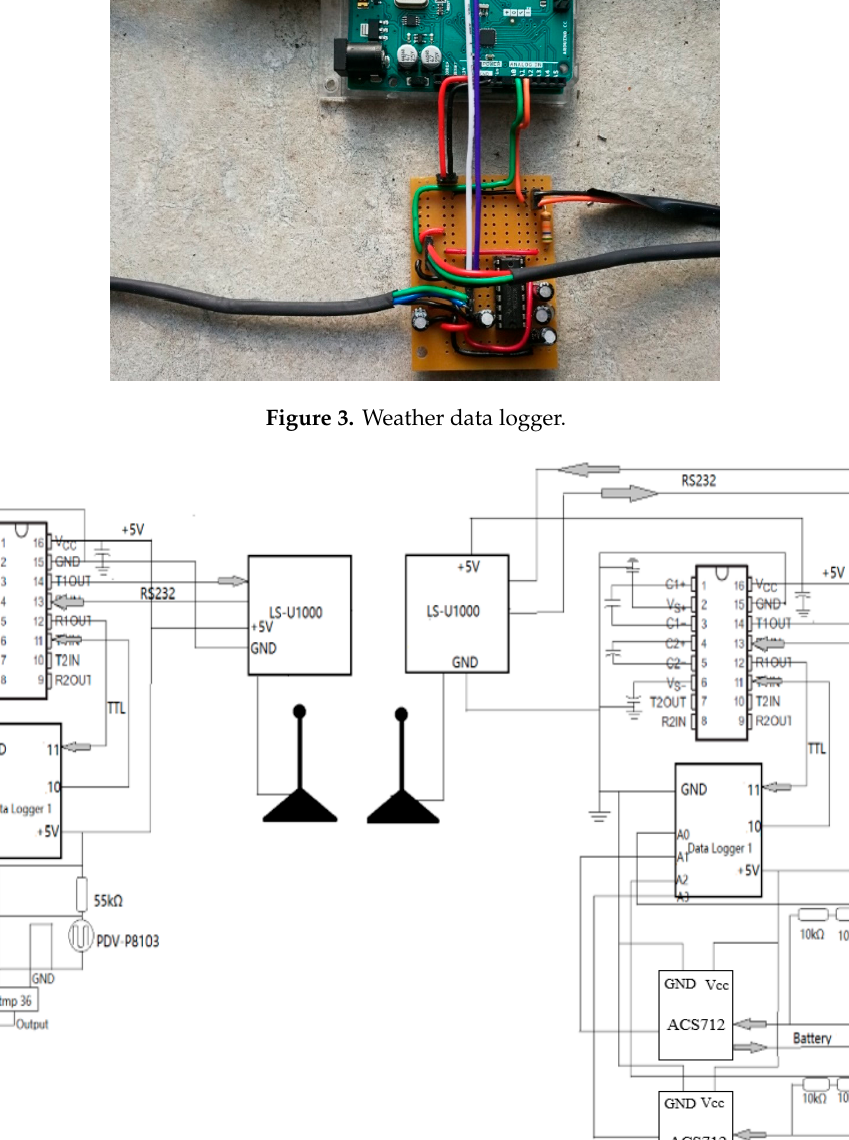
Figure 4. Detailed wiring diagram of data logging system.